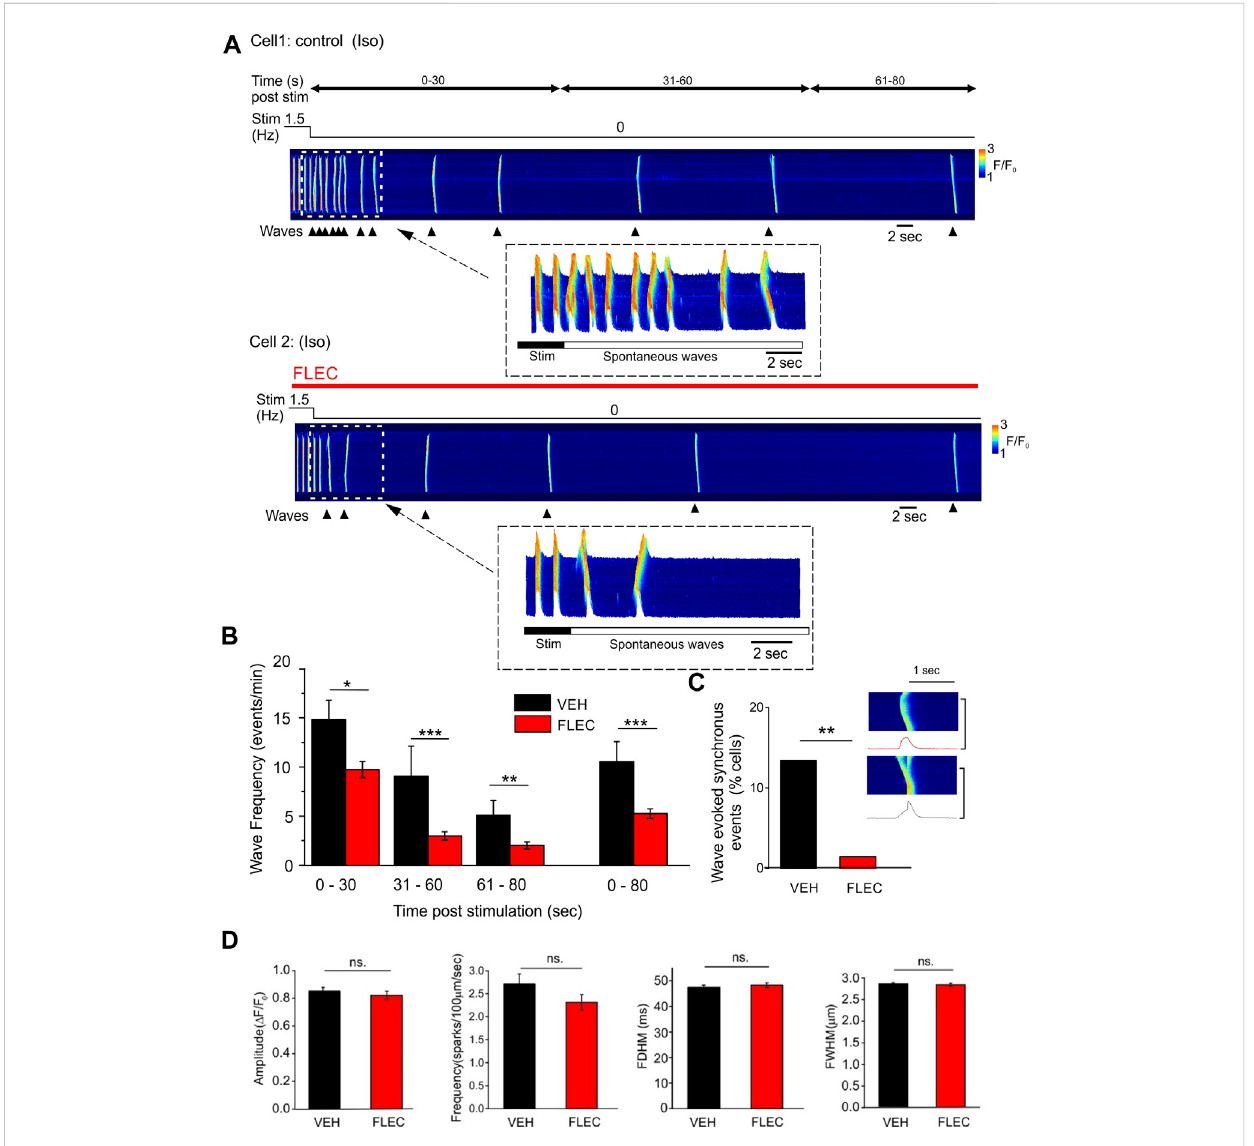
FIGURE 4 Flecainide decreases Ca 2+ wave frequency in intact ARVM without affecting spark properties (A) , Representative line scan images showing spontaneous Ca 2+ waves post-pacing (1.5 Hz) in the presence of isoproterenol (ISO) and either vehicle (VEH, upper ) or fl ecainide (FLEC, lower ). (B) , Cumulative data showing the mean wave frequency at various time intervals post-pacing in the presence of either vehicle or fl ecainide. (C) , Cumulative data showing the percentage of cells exhibiting in which a Ca 2+ wave triggered a rapid uniform Ca 2+ transient. Insert shows line scan images in the same cell of a Ca 2+ wave ( upper ) and a wave triggering a uniform Ca 2+ transient. (D) , Cumulative data showing that fl ecainide had no signi fi cant effect on the amplitude ( Δ F/F 0 ), frequency, duration (FDHM) or width (FWHM) of spontaneous Ca 2+ sparks. * = p < 0.05; ** = p < 0.01; *** = p < 0.001. Control/ vehicle n = 68 (10), fl ecainide n = 68